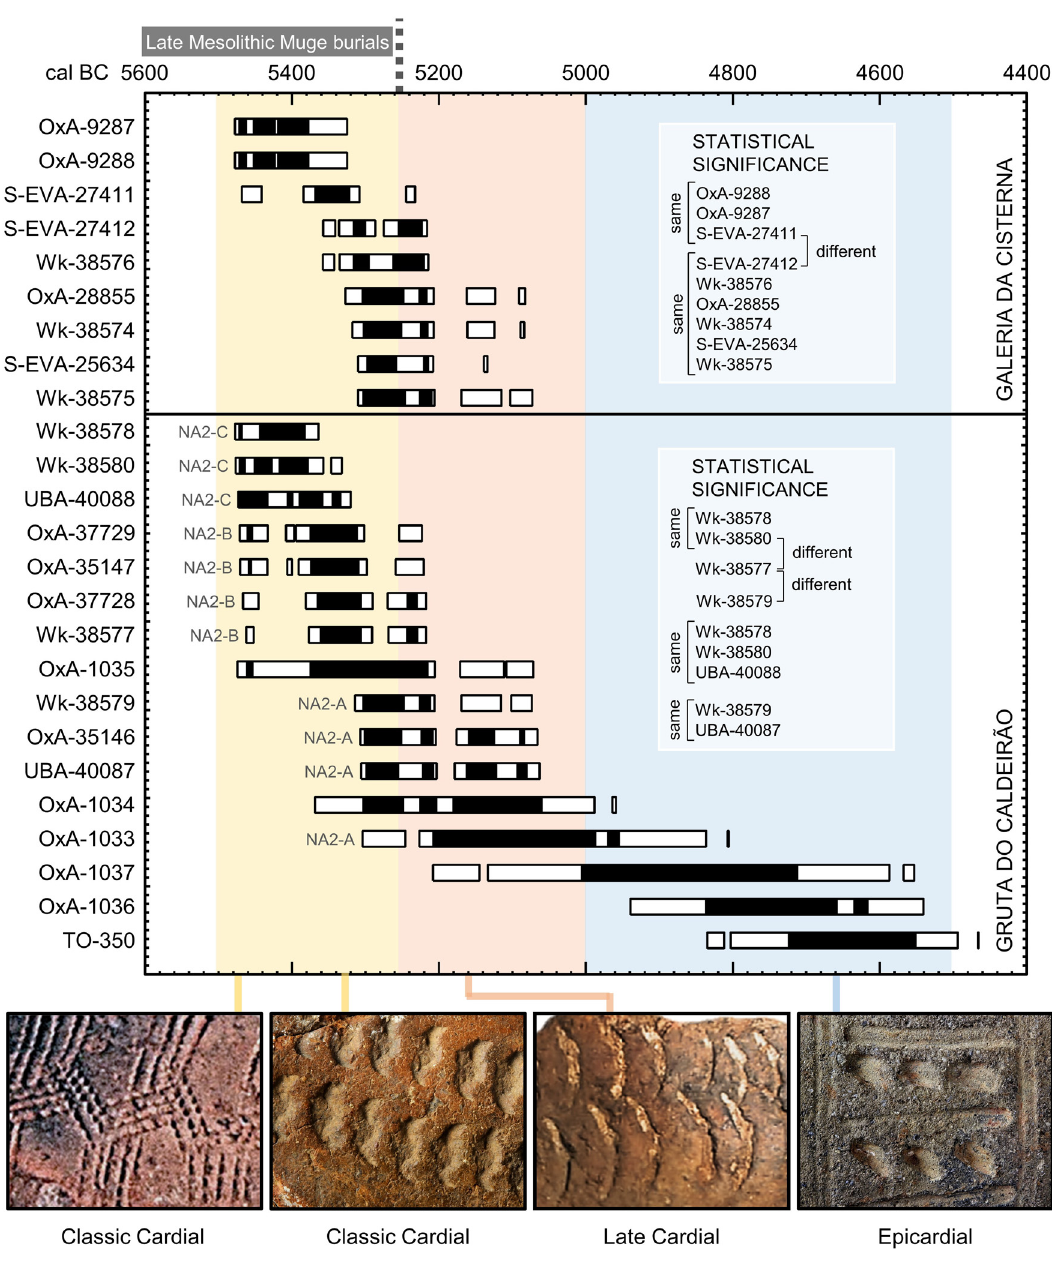
Figure 8: Calibrated radiocarbon ages and periodisation of the Early Neolithic in Central Portugal. Calibration used the IntCal20 Northern Hemisphere curve in Calib 8.1 for Windows ( Reimer et al., 2020; Stuiver & Reimer, 1993 ) . The directly dated human bones based on which the funerary activity of horizon NA2 times could be phased are labelled accordingly. The upper chronological boundary of Mesolithic burial activity at Muge is taken from Peyroteo - Stjerna ( 2020 )